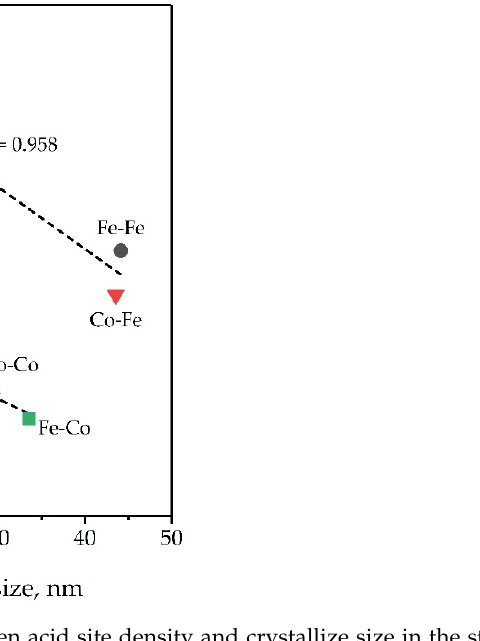
Figure 9. Relationship between acid site density and crystallize size in the studied porous hexacyanometallates(III).